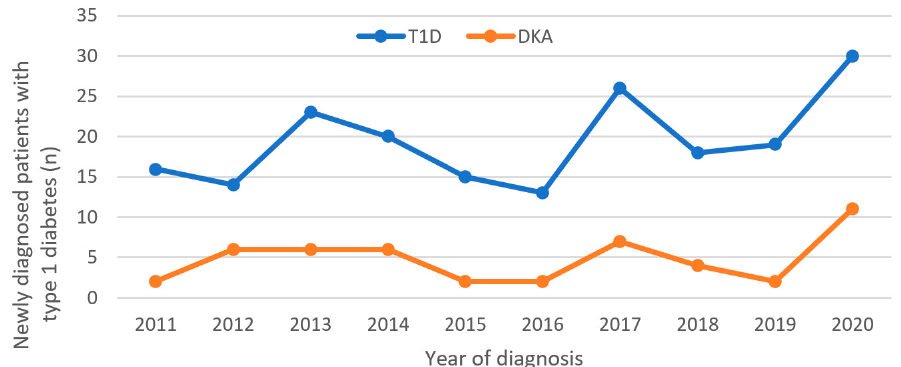
Figure 1. Number of children with newly diagnosed type 1 diabetes in Department of